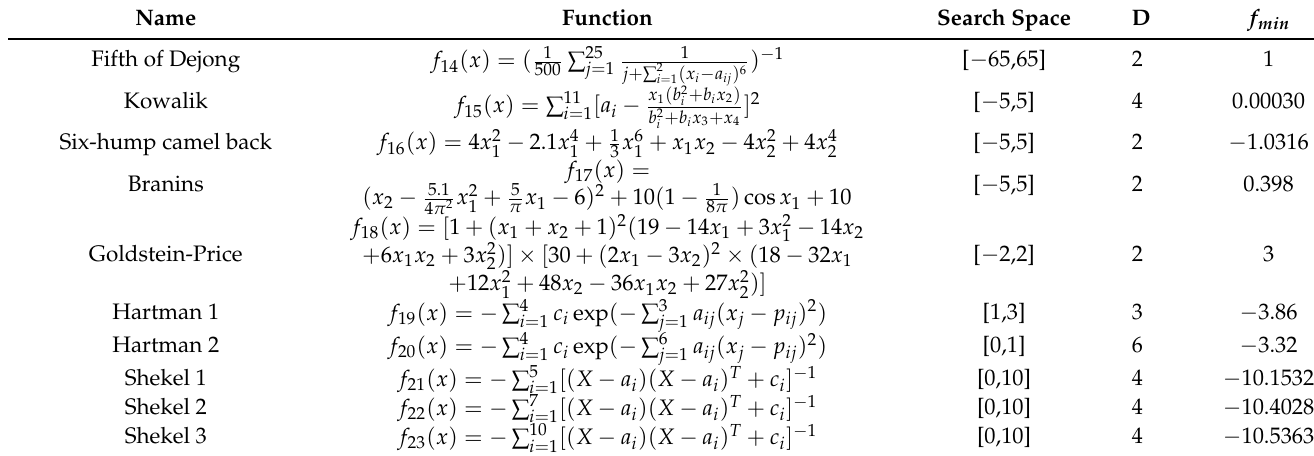
Table 12. Multimodal benchmark functions in low